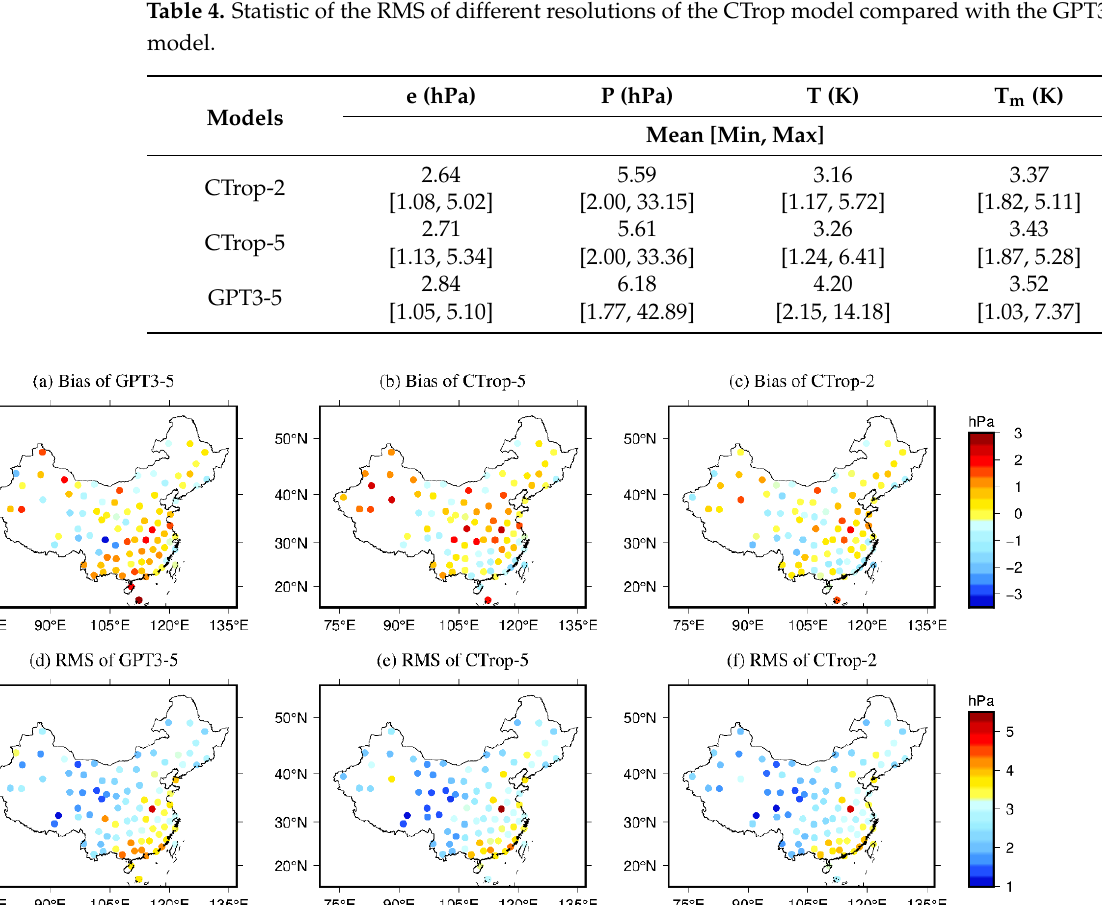
Figure 11. Distribution of the performance of water vapor pressure in different resolutions of the CTrop and GPT3 models validated by radiosonde sites in 2017: ( a ) Bias of GPT3-5; ( b ) Bias of CTrop-5; ( c ) Bias of CTrop-2; ( d ) RMS of GPT3-5; ( e ) RMS of CTrop-5; ( f ) RMS of CTrop-2. The positive bias means the model outputs are larger than the reference values, while the negative bias means they are smaller than the reference values.